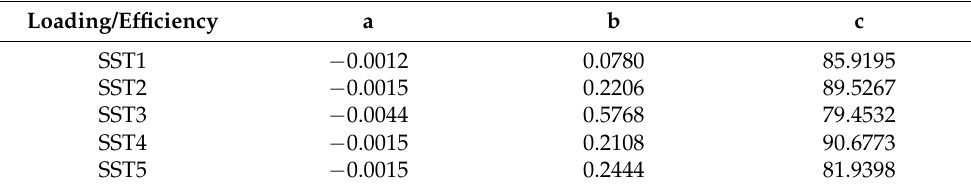
Figure 8. Load optimization using ALO without scheduling of SSTs. Table 2. Efficiency vs. loading capability equation configuration